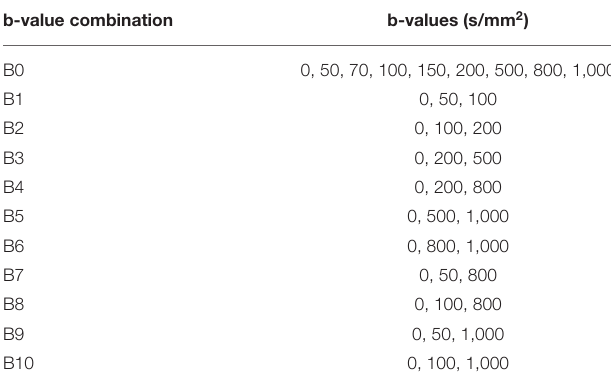
TABLE 1 | Different b-value combinations for ADC